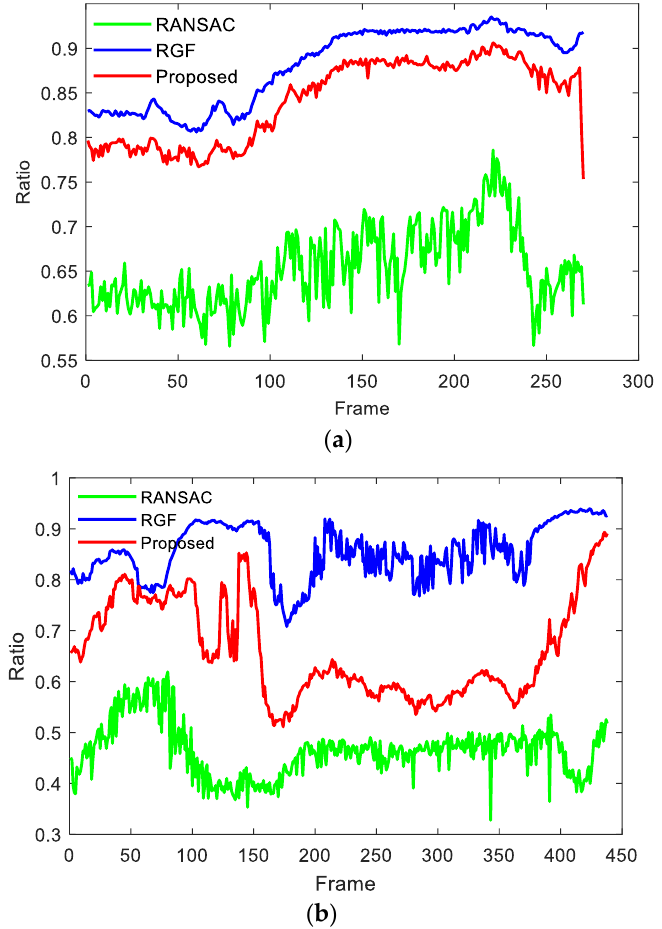
Figure 6. The ratio of ground points in two KITTI dataset. ( a ) The ratio of ground points in 2011_09_26_drive_0018 . ( b ) The ratio of ground points in 2011_09_26_drive_0051.